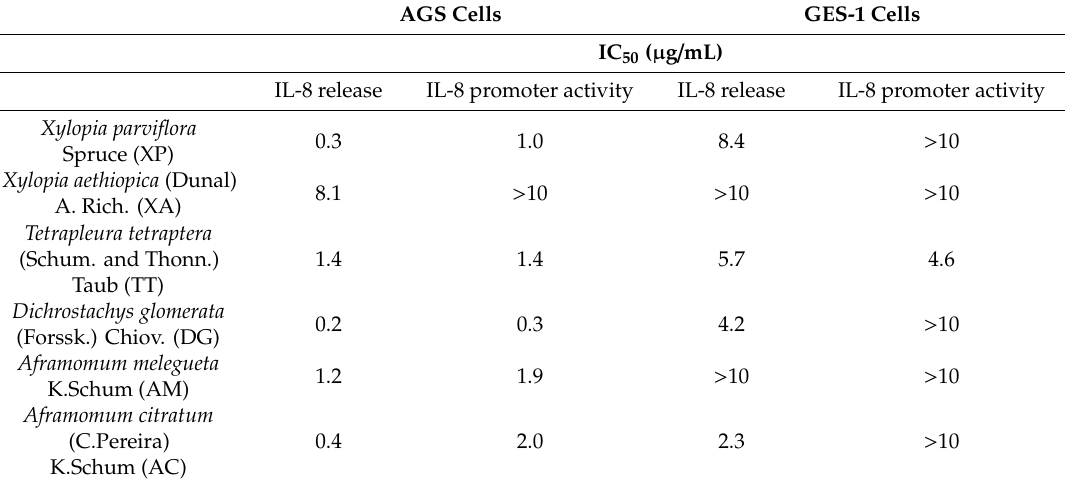
Table 2. Half-maximal Inhibitory Concentration (IC 50 ) ( µ g / mL) of the extracts on the TNF α -induced IL-8 release and expression in human gastric adenocarcinoma (AGS) and gastric epithelial (GES-1)